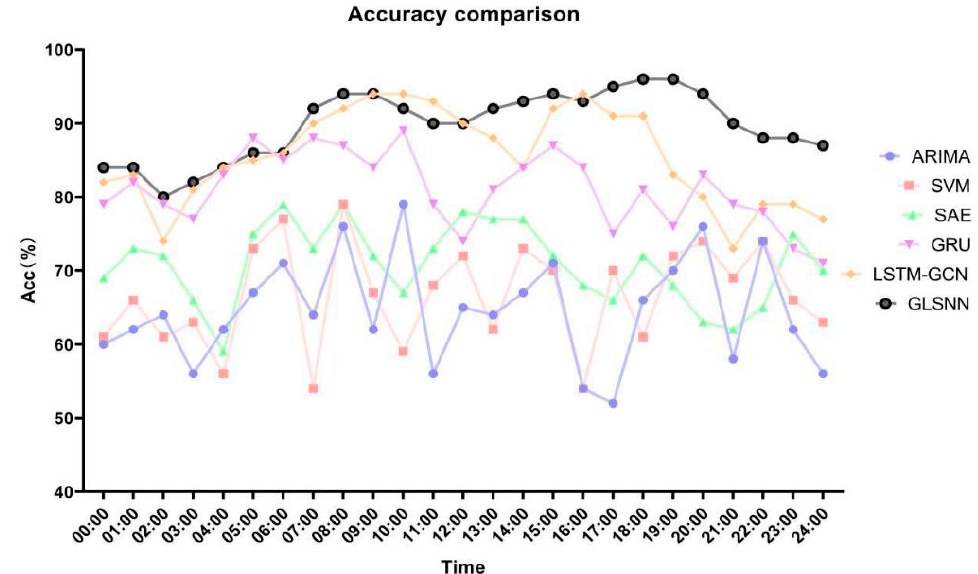
Figure 6. Prediction accuracy comparison. The Acc indicates the accuracy of the model’s prediction results.